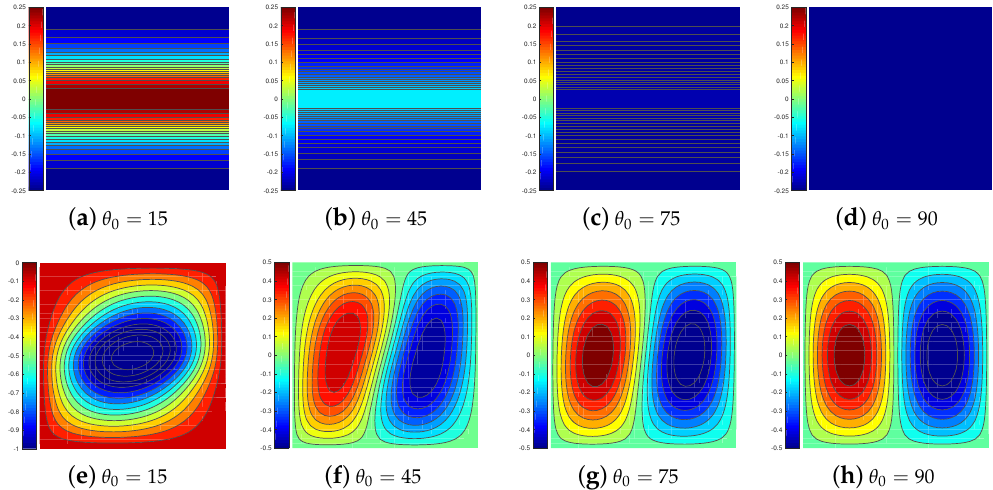
Figure 9. Pre-buckling and buckling results for SSSS variable-stiffness configurations, b / h = 50, and [ ± < θ 0 | 90 > y ] s : ( a )–( d ): pre-buckling distribution of internal forces N xx , ( e )–( h ): buckling